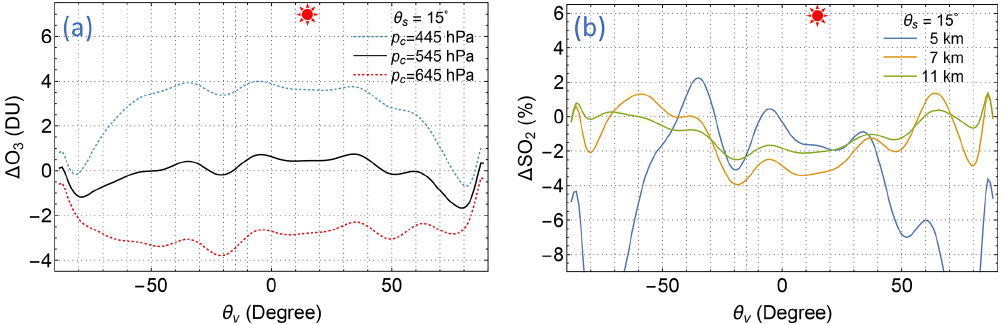
Figure 21. Errors in retrieved O 3 and SO 2 due to MLER treatment of clouds, which are represented by 1.5km thick C1 particle layers with an optical thickness τ = 15 at 340nm. (a) O 3 errors in DU for correct ( p c = 545hPa) and biased ( p c = 545 ± 100hPa) cloud OCPs. (b) SO 2 errors in percent for SO 2 layers at three altitudes (5, 7, and 11km) above a layer of cloud (at 3km altitude). See the Fig. 4 caption for the specification of viewing and illumination